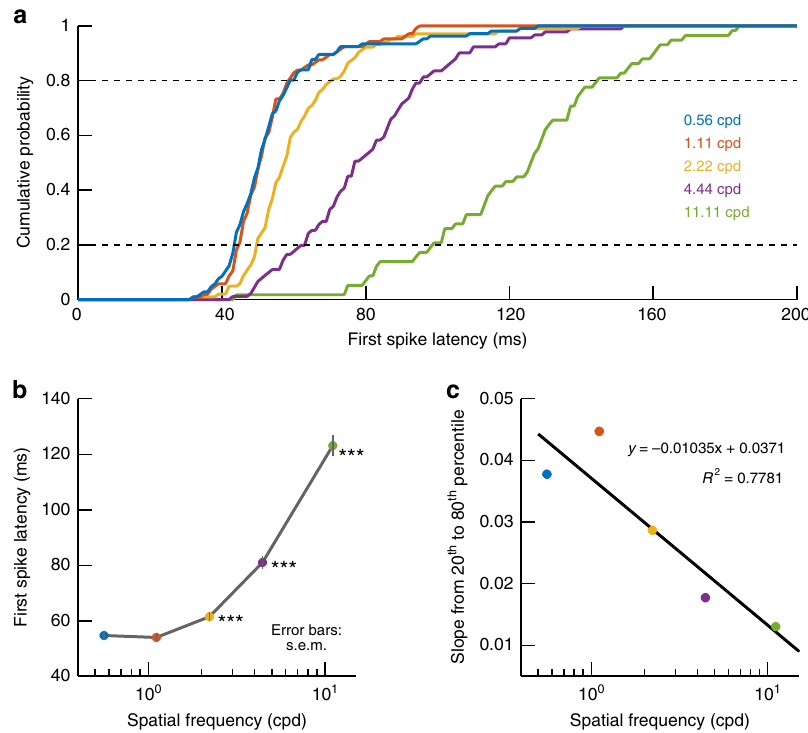
Fig. 4 Early visual sensation for low spatial frequencies by the primate SC. a Cumulative histograms of fi rst-spike latency (Methods) across neurons, separated by spatial frequency. For each neuron, we measured the average fi rst-spike latency of the evoked visual response after a given spatial frequency grating was presented on multiple trials. We then repeated the measurement for other spatial frequencies. The evoked response consistently came earlier for low spatial frequencies than for high spatial frequencies. b The rank-ordering of spatial frequencies in a is also seen when plotting mean fi rst-spike latency across all neurons as a function of spatial frequency. Low spatial frequencies evoked a visual response earlier than high spatial frequencies. Error bars denote s.e.m. across neurons, and asterisks indicate p < 0.001 when comparing fi rst-spike latency for 0.56 cpd to that in each of the other spatial frequencies. c Variability of fi rst-spike latency was higher for higher spatial frequencies. We plotted the slope of the cumulative histograms in a between the 20th and 80th data percentiles as a function of spatial frequency. This slope progressively decreased, suggesting a progressive increase in fi rst-spike latency variability across neurons with higher spatial